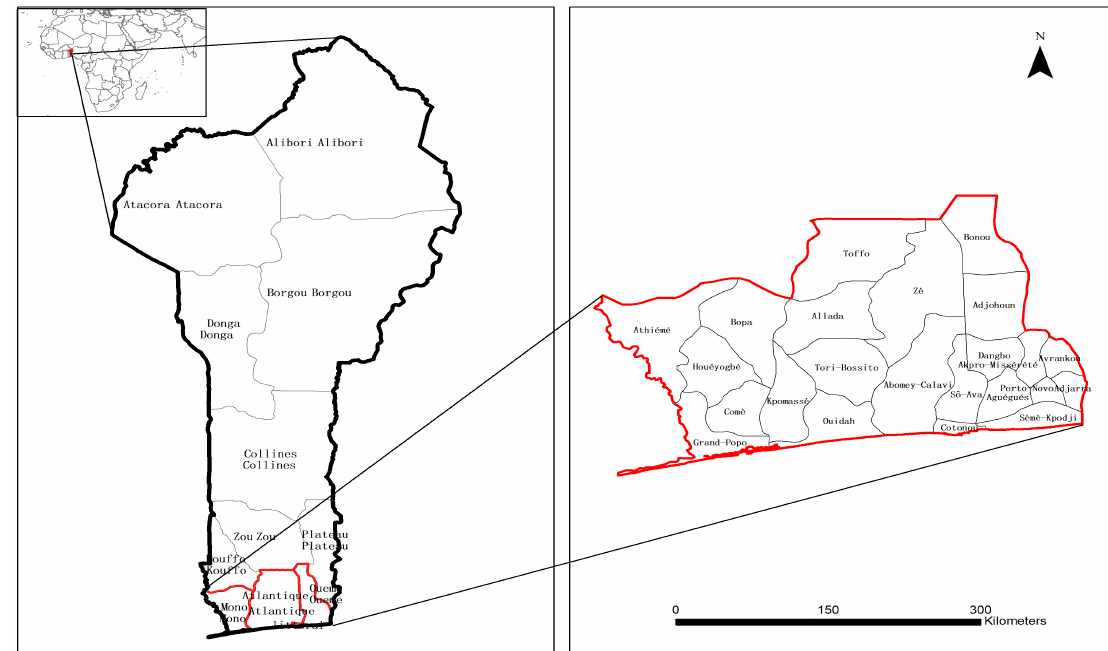
Figure 1. The study area of the tropical coastal zones of Benin.